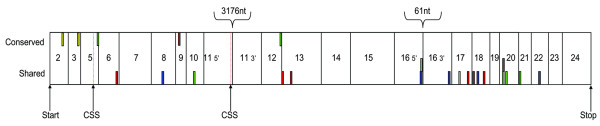
Shared and conserved predicted ESEs in the human and mouse BRCA1 genes. The BRCA1 open reading frame (ORF) divided into exons is shown to scale, with shorter analyzed fragments of exons 11 and 16. Conserved exonic splicing enhancers (ESEs) are shown on the top of the ORF, with shared ESEs shown on the bottom. Overlapping ESE motifs are staggered. SF2/ASF ESE motifs are shown in red, with SC35 in blue, SRp40 in green and SRp55 in yellow, also to scale. Cryptic splice sites (CSSs) in exons 5 and 11 are marked. Only the sequence within 125 nucleotides (nt) of exonic splice donor and acceptor consensus sequences has been analysed. Conserved ESEs are those sequences that were identical in human, primates, mouse cow, dog and opossum Brca1. Shared ESEs are those sequences for which ESEfinder predicted a binding site for the same arginine-serine rich protein (SR protein) to the same exon position but the motif sequence was not the same between species.